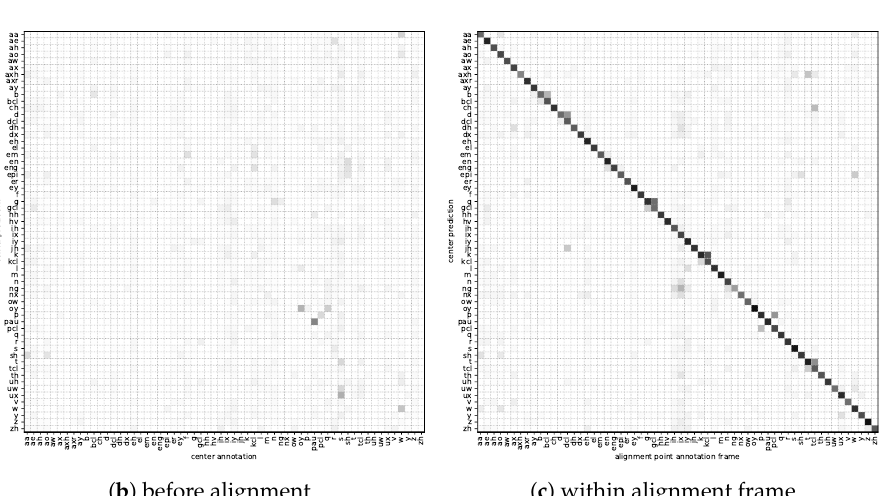
Figure A2. Alignment evaluation overview for model W2P_shallow. For each predicted phoneme on the y -axis the relative frequency of the corresponding phoneme annotation on the x -axis. Color scale [0, 1] from white to